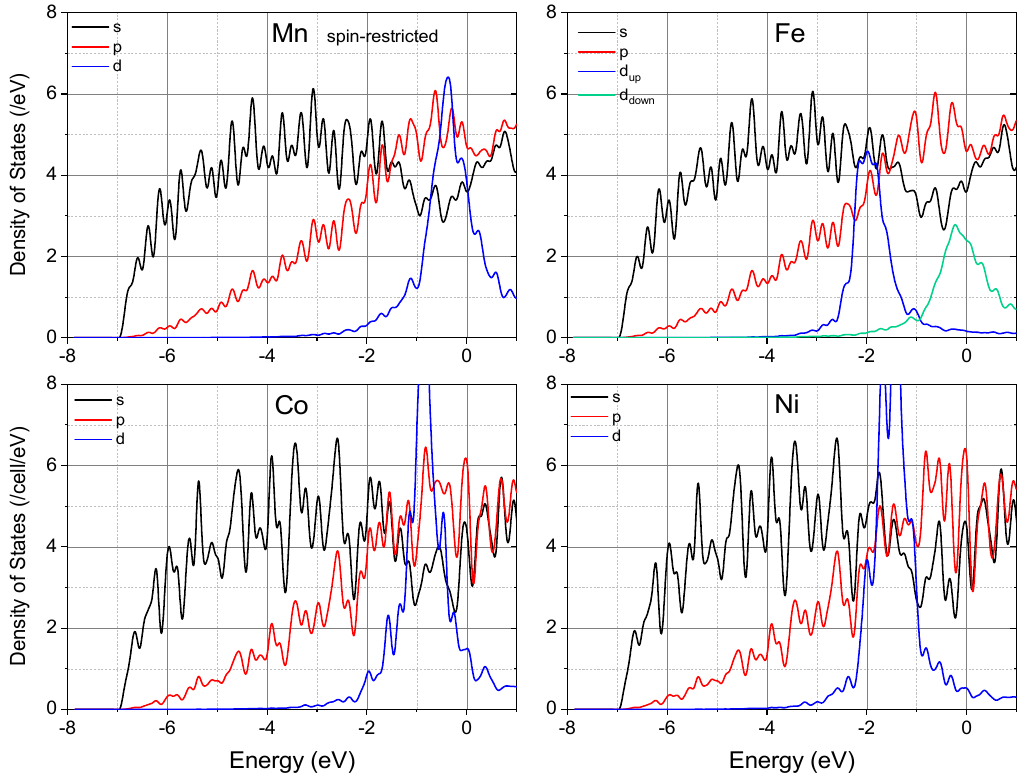
Figure 6. The partial density of states of the supercell with segregation of alloying elements at the (2114) twin boundary in Mg. Note that the spin-up and spin-down d states of Fe are colored differently. Fermi energy is set to zero.